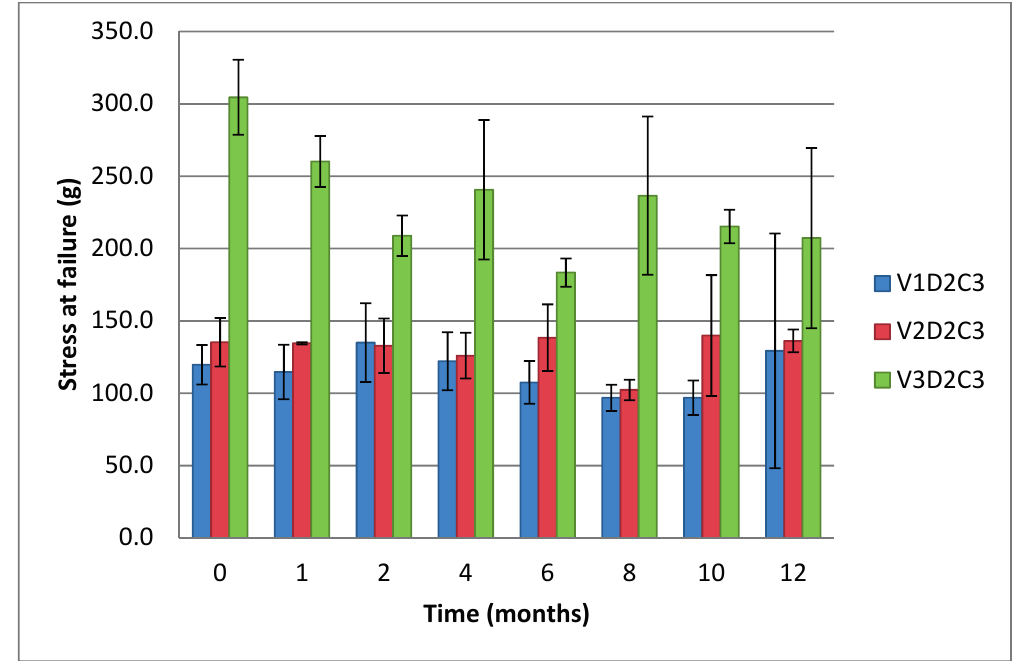
Figure 8. Comparison of stress at failure over 12 months for cylindrical gels of 1% (w/w) chitosan of variable molecular weight at 3% theoretical DES crosslinking.